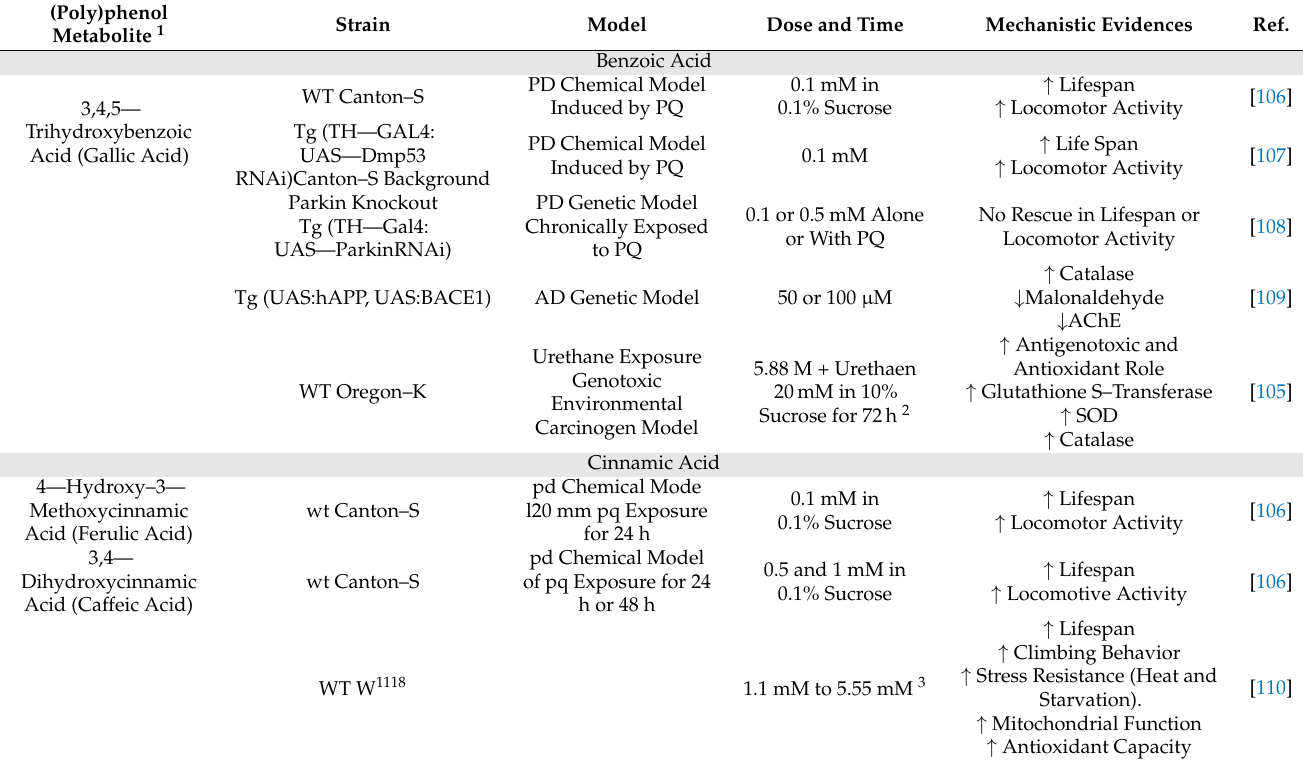
Table 4. Effects of low molecular weight (poly)phenol metabolites on models of neurodegeneration in